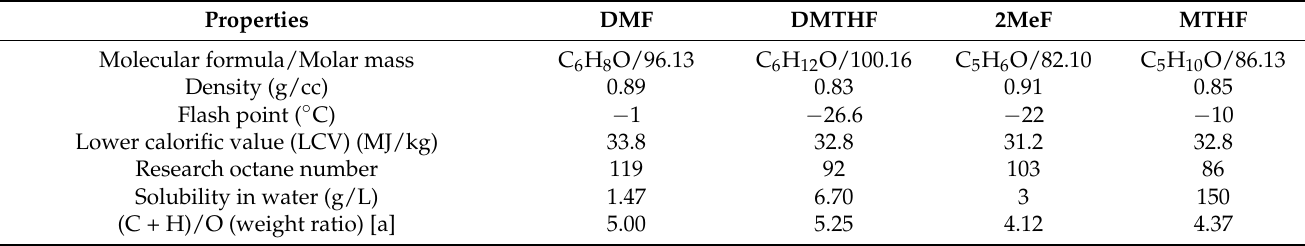
Table 5. Physicochemical and thermal properties of selected furanic